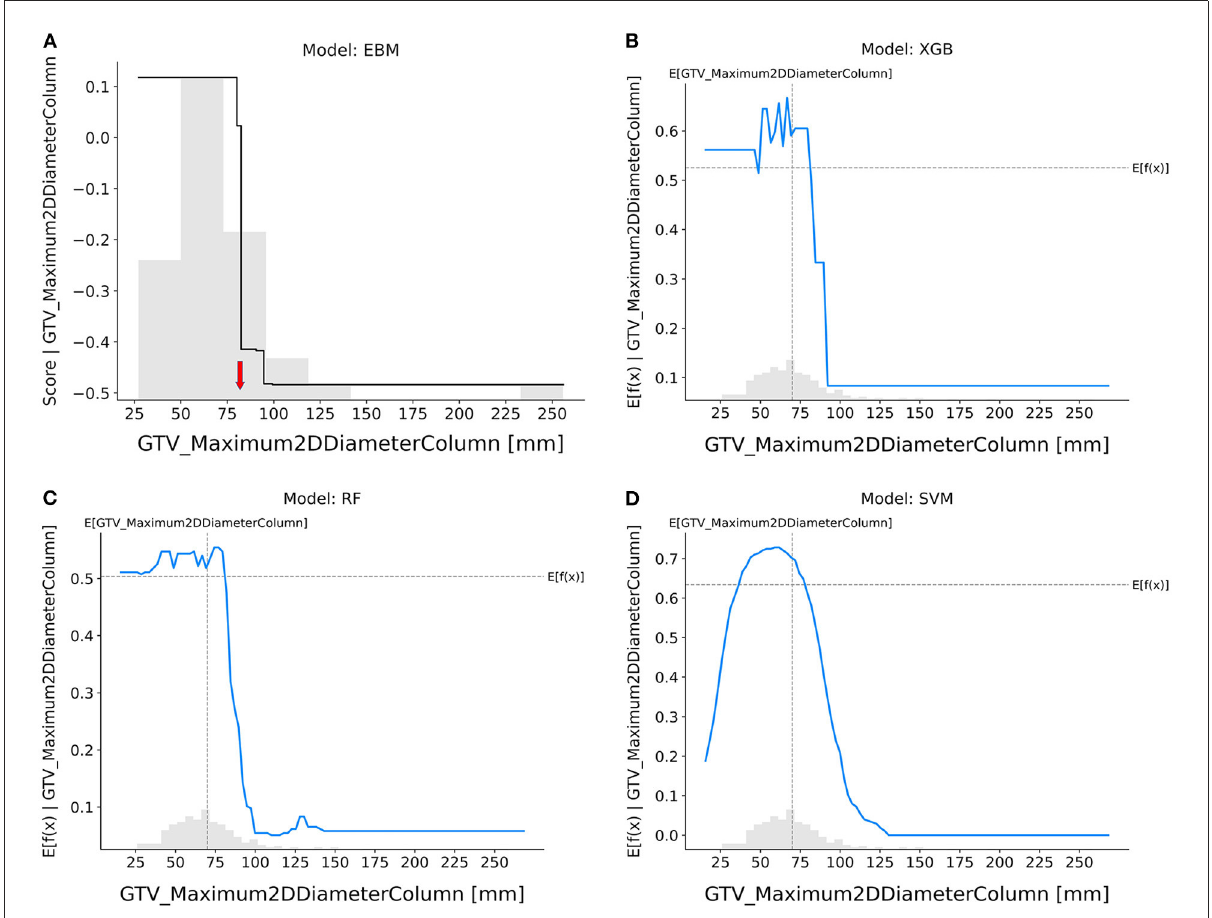
FIGURE4 Response score plot for GTV_maximum2DDiameterColumn. (A) EBM shape function and SHAP partial dependence functions for the (B) XGB, (C) RF, and (D) SVM